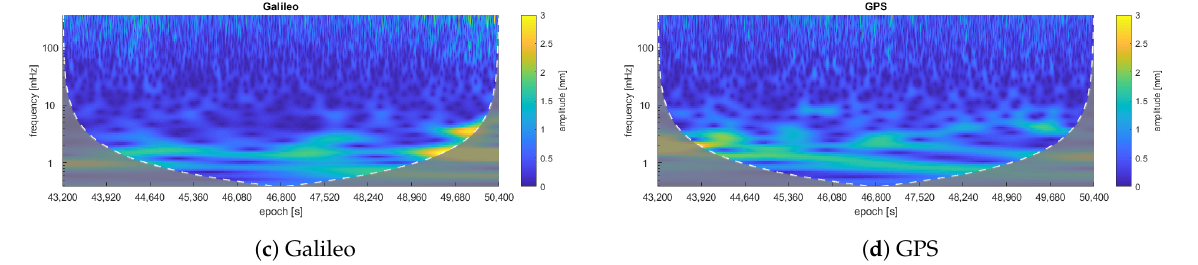
Figure 14. Vertical components ( a ), skyplot ( b ) and scalograms for Galileo ( c ) and GPS ( d